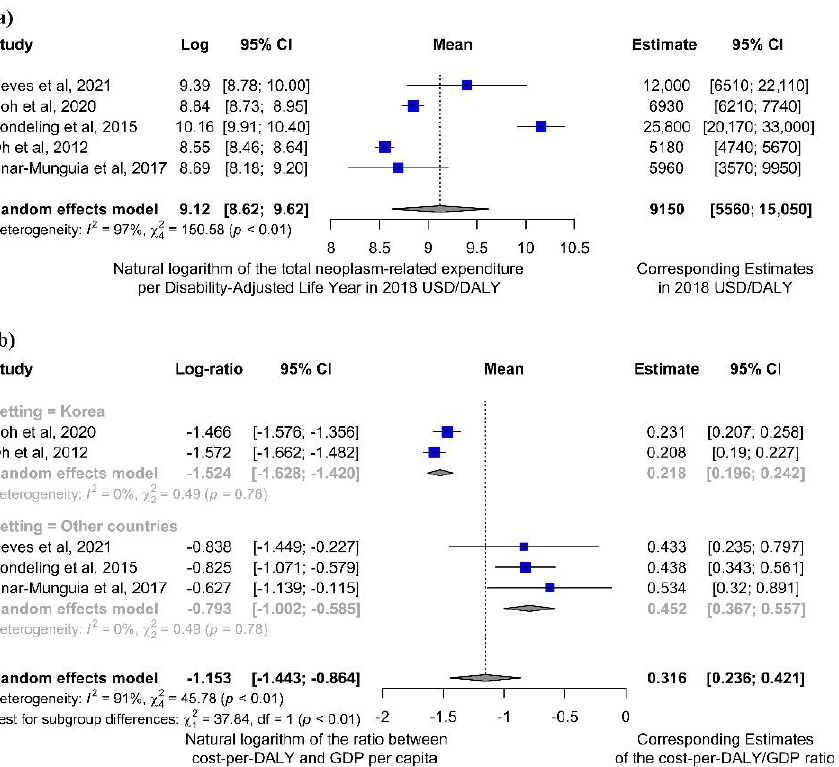
Figure 2. Forest plots for outcomes related to the cost-per-DALY ratio, according to meta-analytic computations described in the Methods. A meta-analytic estimate of the average cost per DALY ascribable to cancer (and its 95% CI), performed considering all studies eligible for the quantitative synthesis [31–35] ( a ). Expenditures per DALY were also considered in relation to the corresponding GDP per capita; ( b ) given that two studies were set in the same context (Korea) [32,34], a post-hoc subgroup analysis was also performed by separating them from other